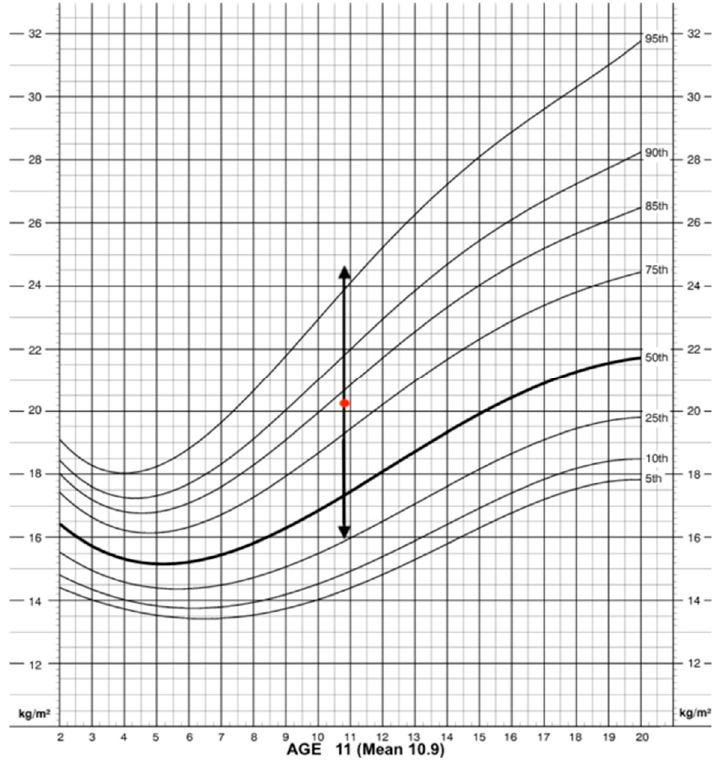
Figure 3. BMI according to percentiles: girls.